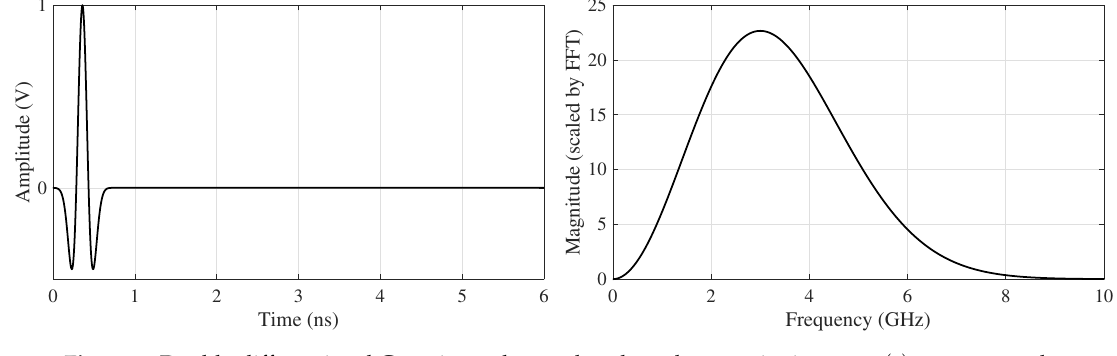
Figure 7. Double-differentiated Gaussian pulse used as the voltage excitation v pulse ( t ) to compute the ( z p , t ) from the simulated electric field data using Equation (4). The time-domain radiated pulses E x pulse representation of the signal ( left ) shows a peak amplitude of 1 V at 0.36 ns, while in the frequency-domain ( right ) the signal has maximum spectral energy at 3 GHz.